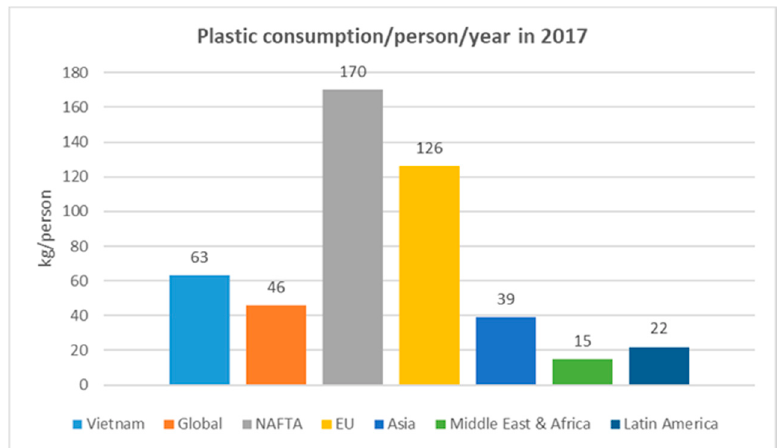
Figure 1. Per capita plastic consumption in 2017 (data from [15]).